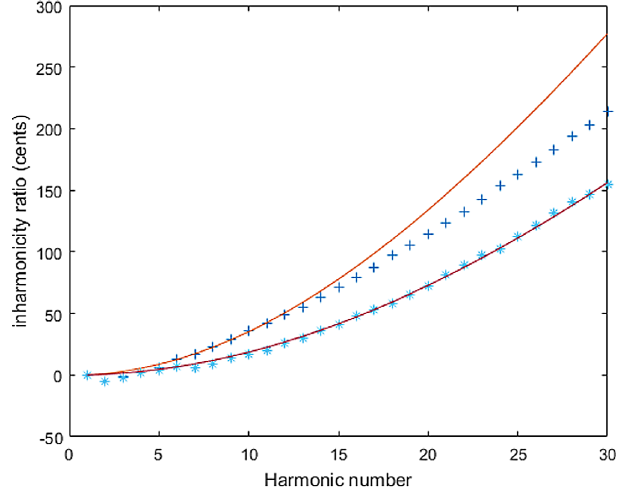
Figure 6. Inharmonicity ratio f n number. +: C0; *: A0. Continuous curves: B = 4.2 (cid:3) 10 (cid:2) 4 and B = 2.2 (cid:3) 10 (cid:2) 4